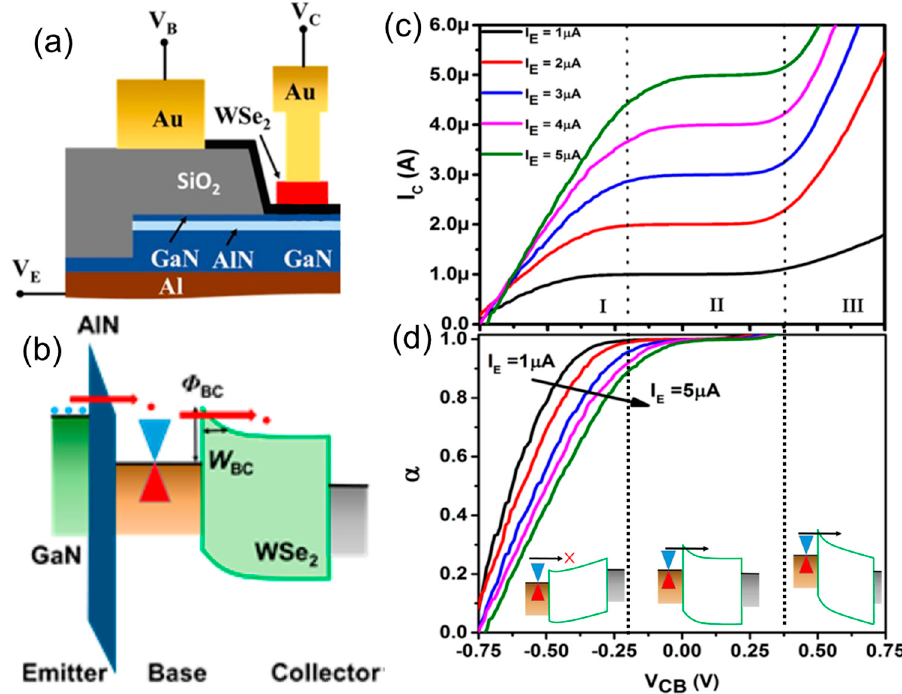
Figure 9. ( a ) Cross-section schematic and ( b ) band diagram of a GBHET based on the GaN/AlN/Gr/WSe 2 /Au stack; ( c ) common-base output characteristics (I C -V CB ) for different values of the emitter injection current I E in the case of a GBHET with a 2.6 nm-thick WSe 2 barrier; ( d ) plots of α = I C /I E as a function of V CB in the same bias range. Images adapted with permission from [103].